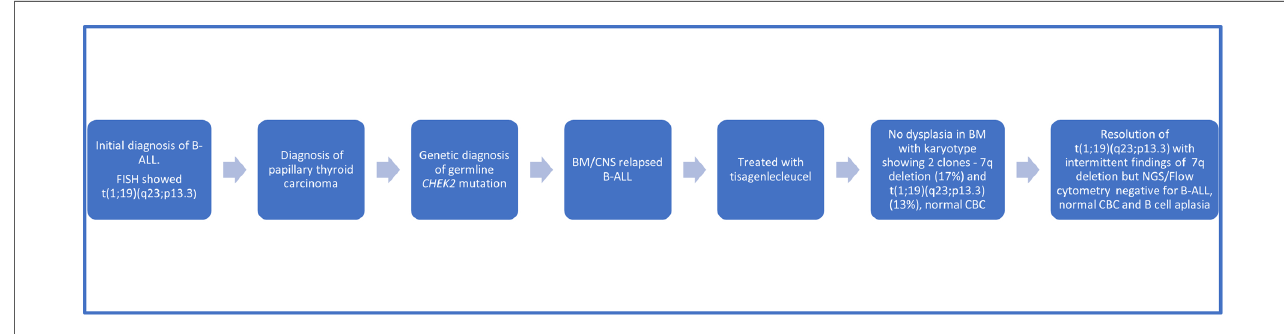
FIGURE 3 Timeline of clinical